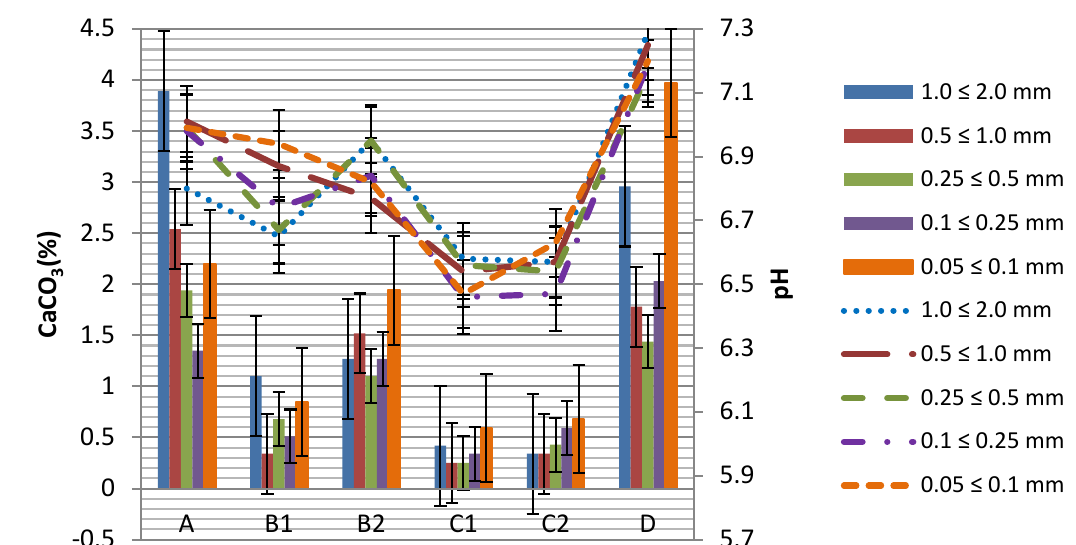
Figure 3. CaCO 3 content (%) and pH value in different fractions 1.0 ≤ 2.0; 0.5 ≤ 1.0; 0.25 ≤ 0.5; 0.1 ≤ 0.25; 0.05 ≤ 0.1 (mm) depending on the sampling location with error bars. Designations: A (inter-railway, depth 20 cm), B1 (5 m from the main track, depth 0–5 cm), B2 (5 m from the main track, depth 20 cm), C1 (embankment, 10 m from the main track, depth 0–5 cm), C2 (embankment, 10 m from the main track, depth 20 cm), D (side track, depth 20 cm).